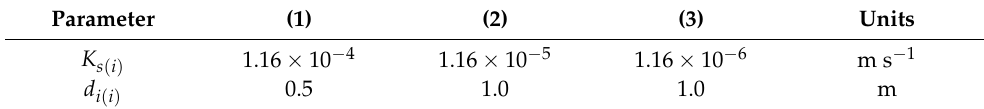
Table 2. Parameters varied for three test cases of rainfall on sloping